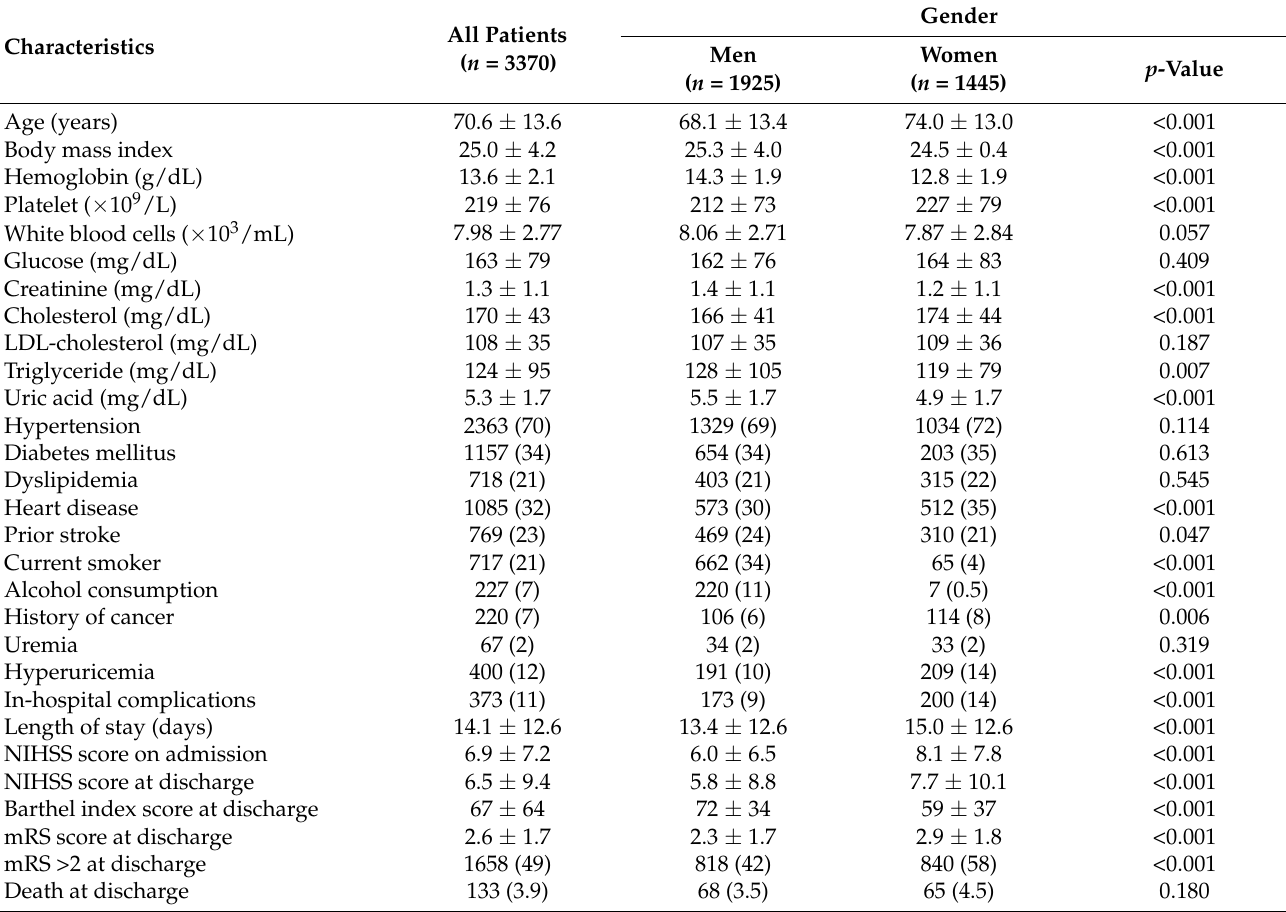
Table 1. Baseline data of clinical features in 3370 patients with acute ischemic